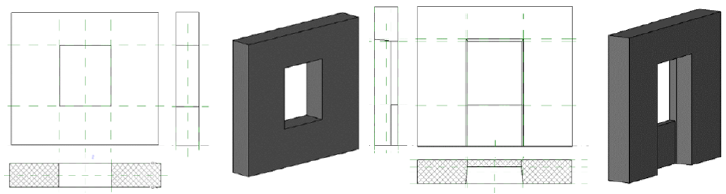
Figure 14. Reduction of the wall thickness (extrusion) and definition of lateral details (sweep).